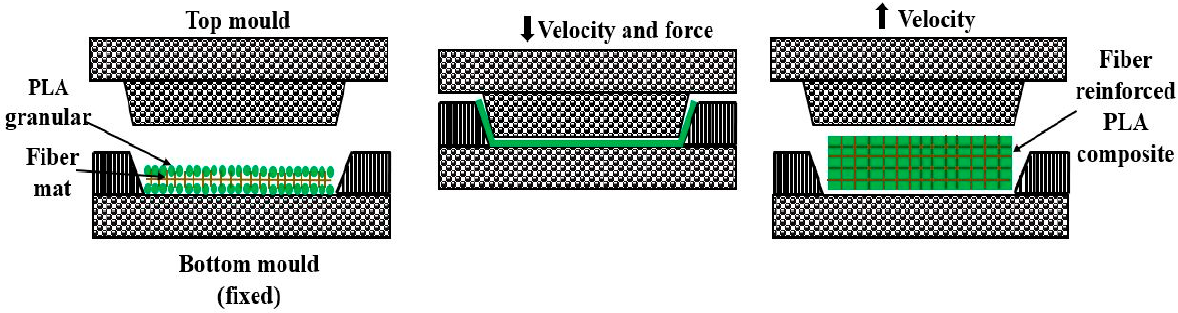
Figure 6. Compression-molding